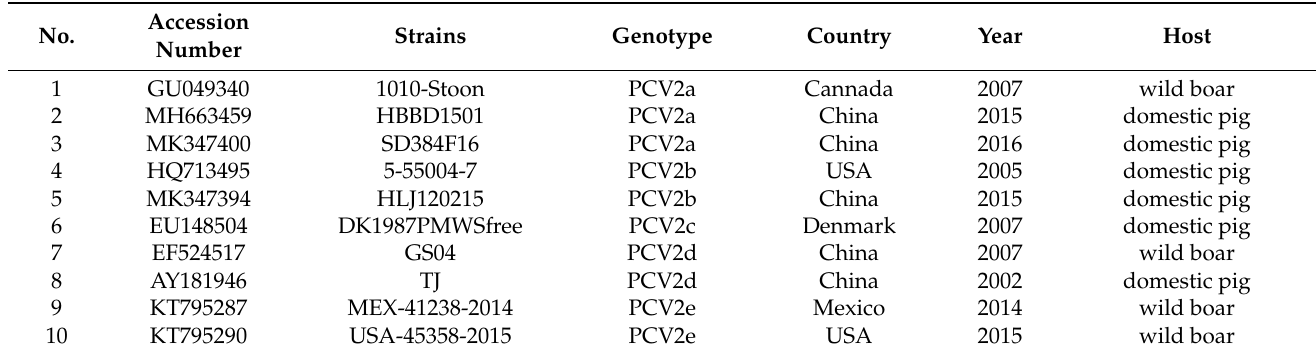
Table 6. The information of 22 referenced PCV2